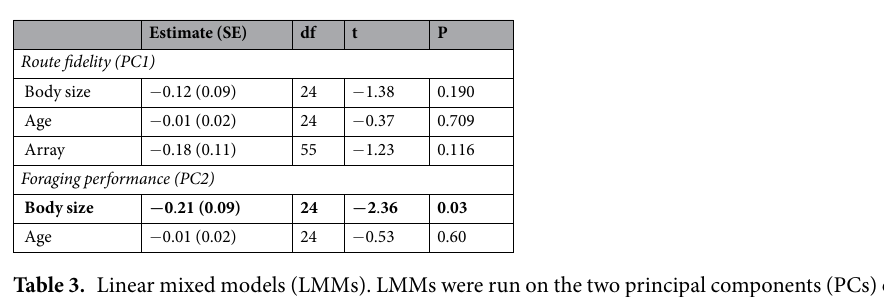
Table 3. Linear mixed models (LMMs). LMMs were run on the two principal components (PCs) of the principal component analysis (PCA), using individual identity nested within colony identity as random variables and age, body size and experimental array as fixed variables. Significant effects are highlighted in